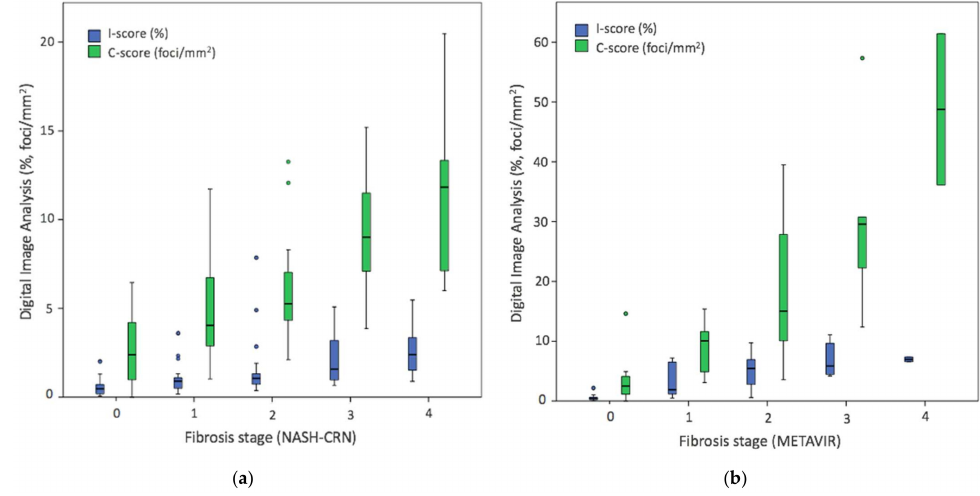
Figure 4. Distribution of digital pathology data across fibrosis histological scores. Boxplot of ( a ) I-score and C-score in NAFLD cohort, ( b ) I-score and C-score in chronic hepatitis cases. Blue boxes correspond to I-score (%CD45+) and green boxes to C-score (clusters proportion)